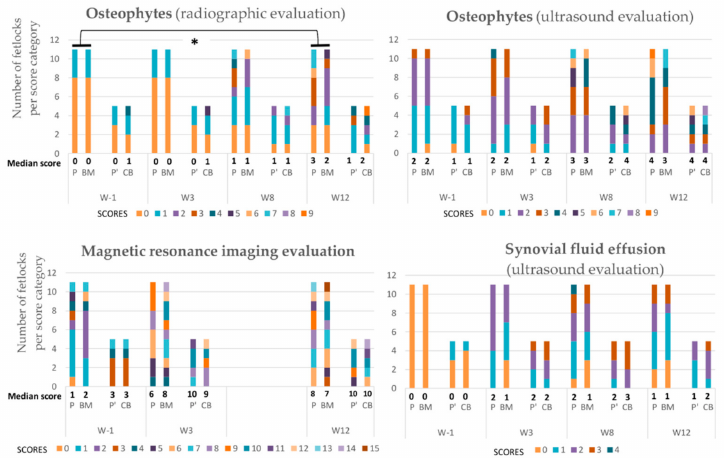
Figure 4. Evolution of the median scores and number of fetlocks per score category obtained for imag- ing parameters over the study period displayed per treatment group and per time point. W—Week; P—Fetlocks injected with placebo, contralateral of the fetlocks injected with bone-marrow derived mesenchymal stem cells (BM-MSCs); BM—Fetlocks injected with BM-MSCs; P’—Fetlocks injected with placebo, contralateral of the fetlocks injected with umbilical cord blood derived mesenchymal stem cells (UCB-MSCs); CB—Fetlocks injected with UCB-MSCs. * Significant difference between paired placebo and mesenchymal stem cell (MSC) treated fetlocks, considering the differences between W12 and W-1 values with p <